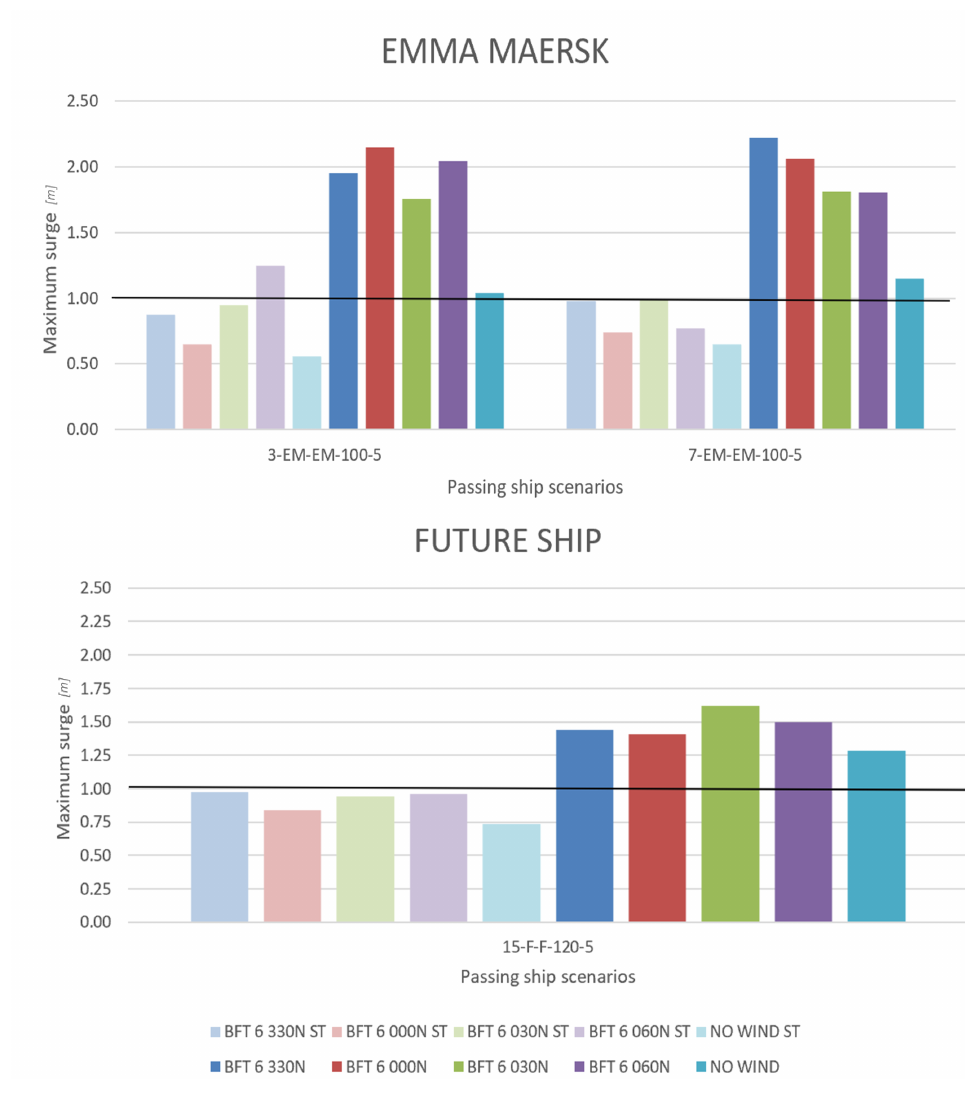
Figure 19. Maximum surge motion results for the Emma Maersk and the future vessel subjected to passing-ship conditions with ShoreTension ®